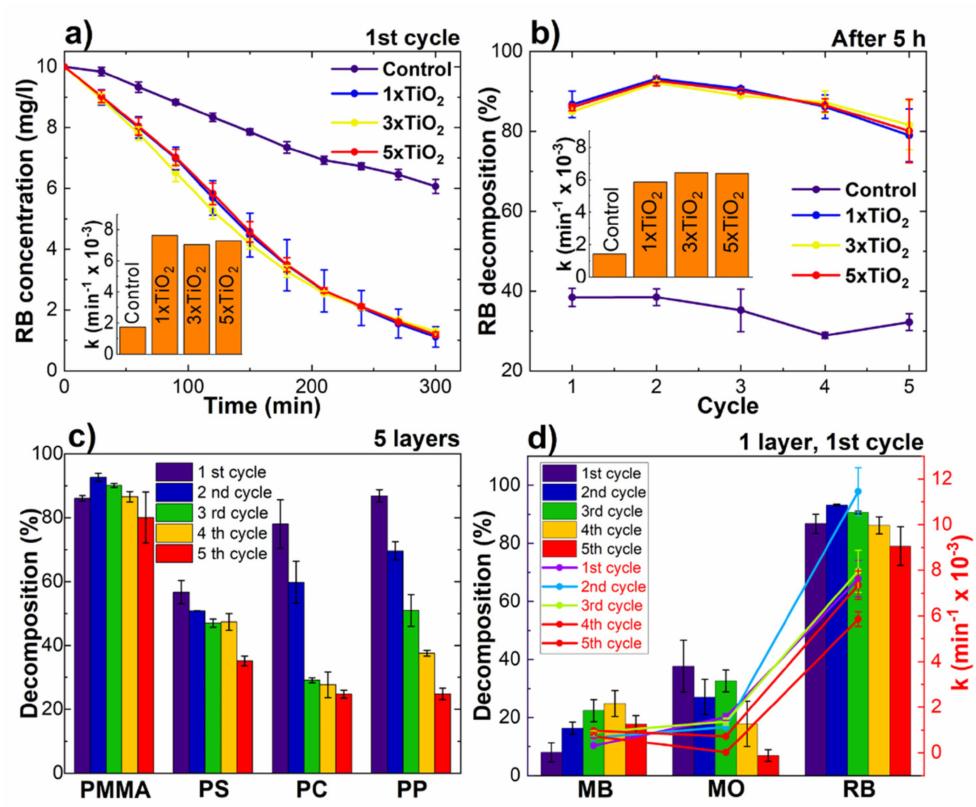
Figure 6. Photocatalytic activity measurements of TiO 2 coatings on the PMMA substrate using RB during: ( a ) the first cycle; ( b ) summary during all five cycles; ( c ) comparison of PMMA and other polymers; ( d ) and comparison between RB and other organic